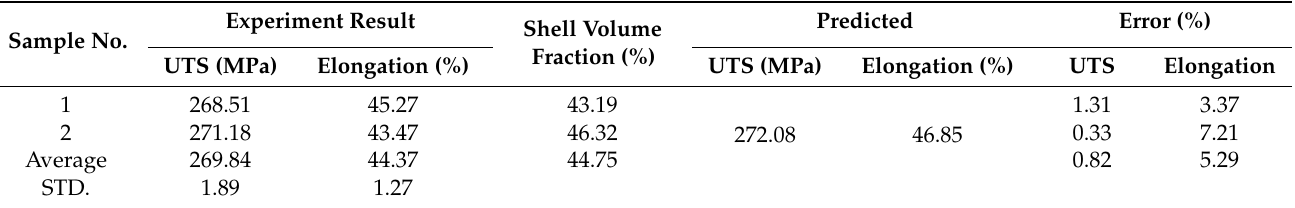
Figure 5. Nominal stress–nominal strain curves in pure Cu prepared using the optimum set of mechanical milling process parameters. Table 7. Microstructural characteristics and mechanical properties of pure Cu specimens prepared by optimum set of process parameters in mechanical